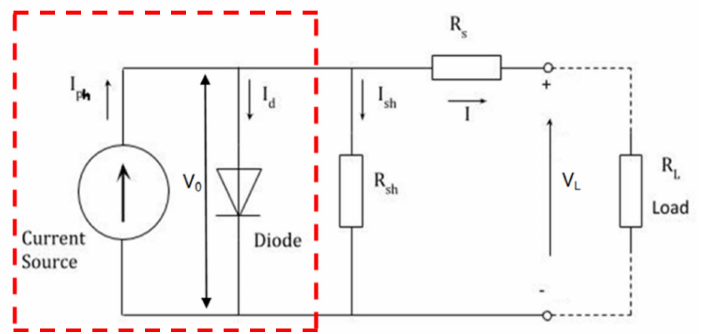
Figure 1. Ideal single diode equivalent circuit of a photovoltaic cell [7,8].